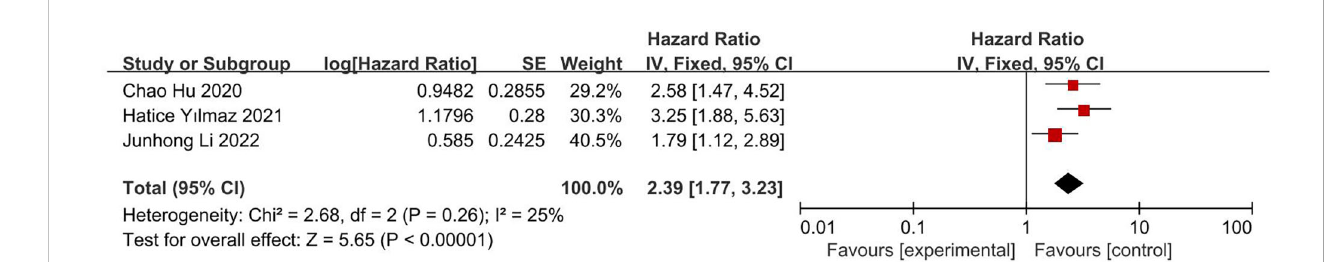
FIGURE 6 Forest plot of correlation between CONUT score and OS in univariate analysis data.